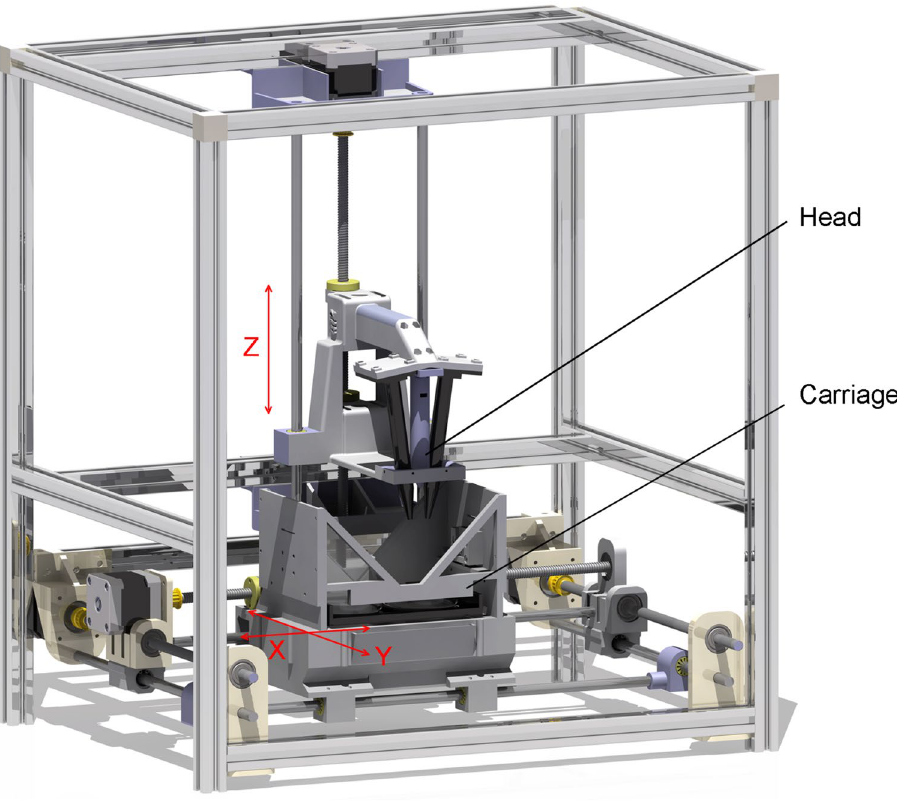
Figure 1. Multi-view cartesian robot. The image was obtained with SOLIDWORKS 2020 SP3.0. This is the general view, showing all components.